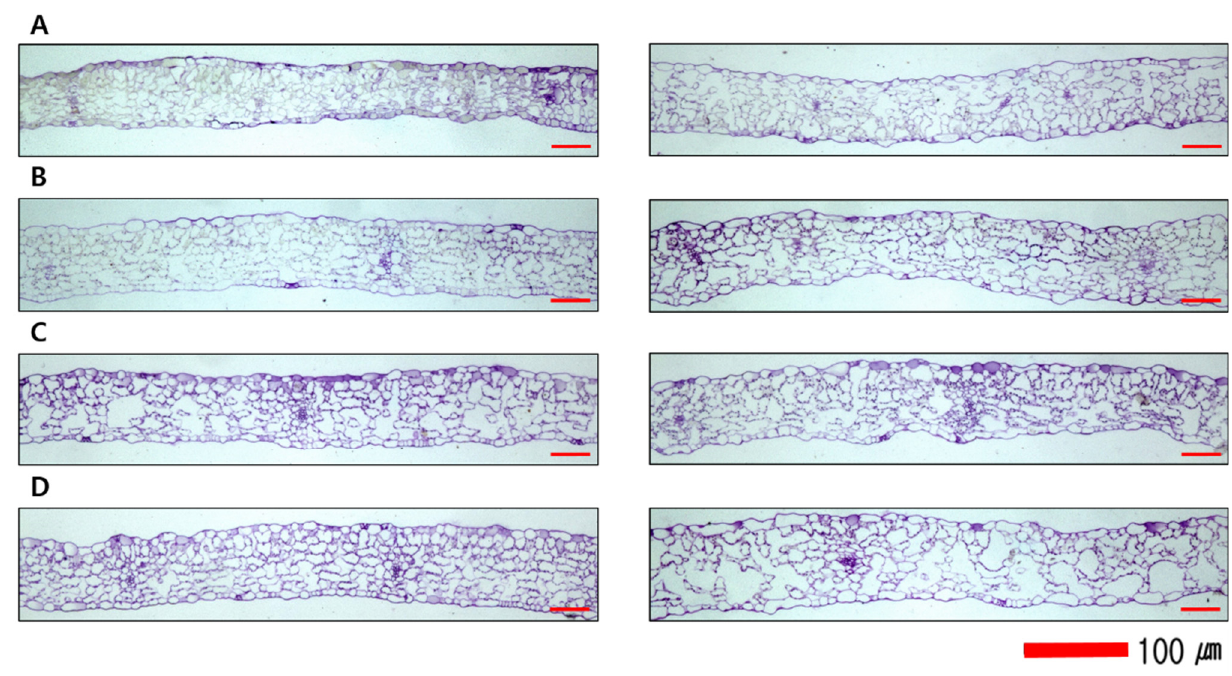
Figure 1. Leaf cross section micrographs of Geockchima ( left ) and Cheongchima ( right ) lettuce cultivars grown in the perlite culture as affected by different amount of nutrient